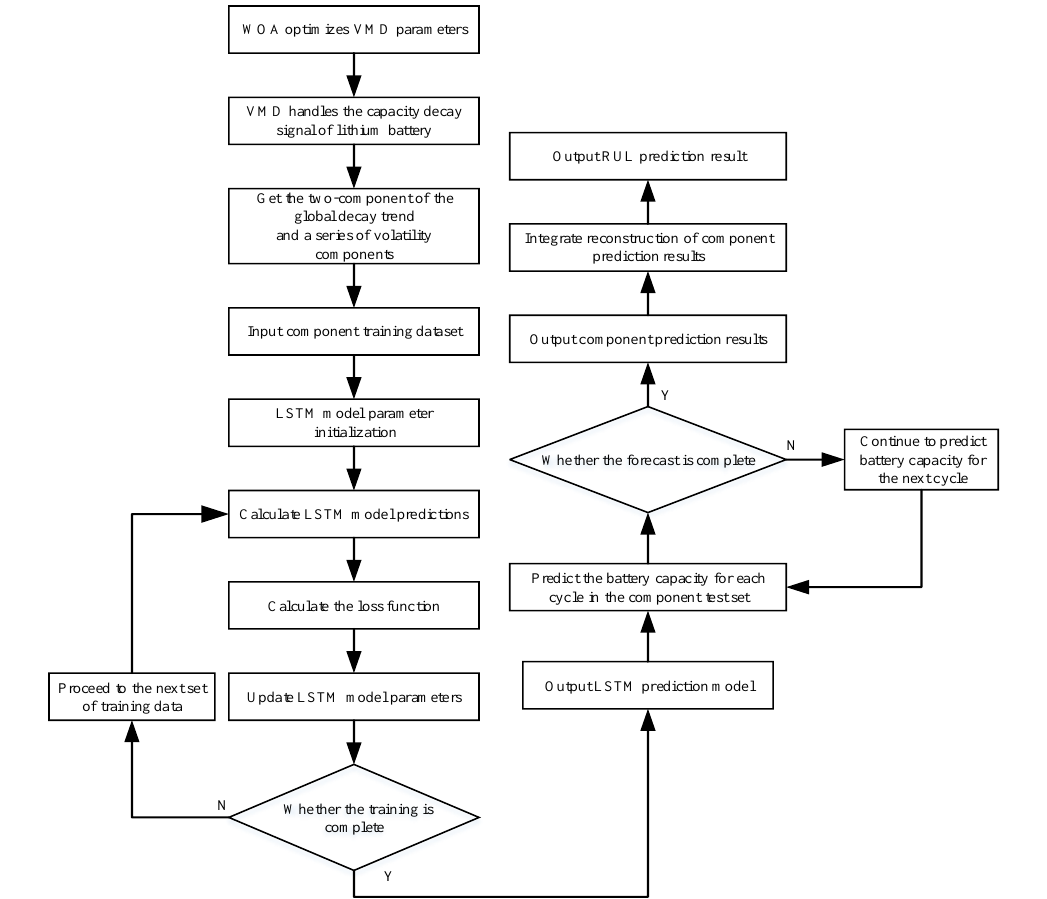
Figure 4. Flowchart of the LSTM model prediction.